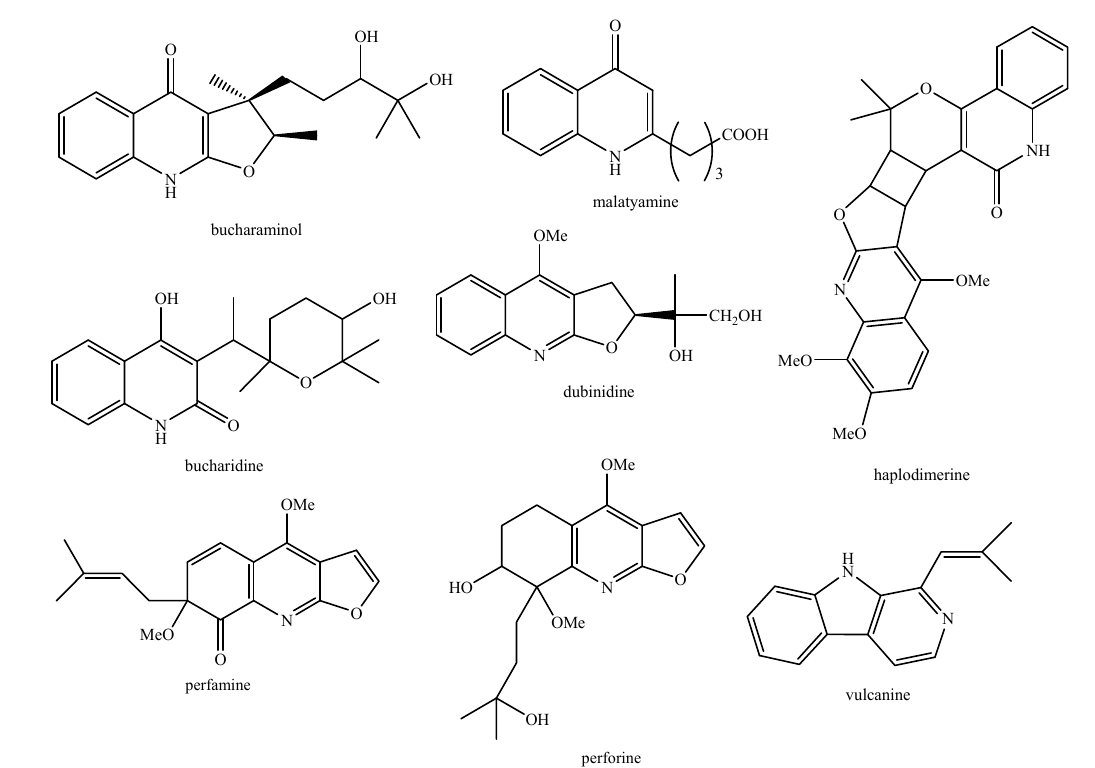
Figure 8. Structure of the alkaloids identified in Haplophyllum species—part 4.